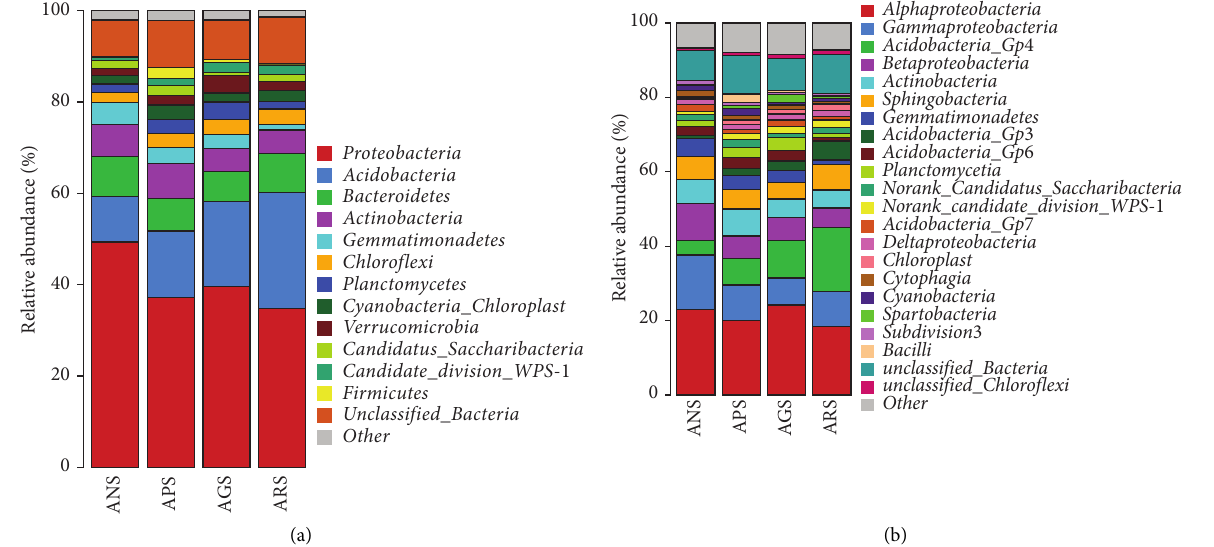
Figure 4: Relative abundance of the taxonomic composition of the bacteria communities at different levels of classification in mine waste slag areas. (a) At the phylum level. (b) At the class